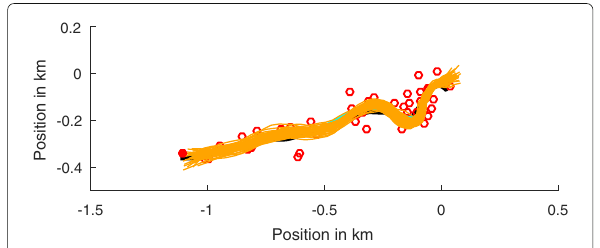
does not cover the true trajectory well. The EnKF is overconfident.